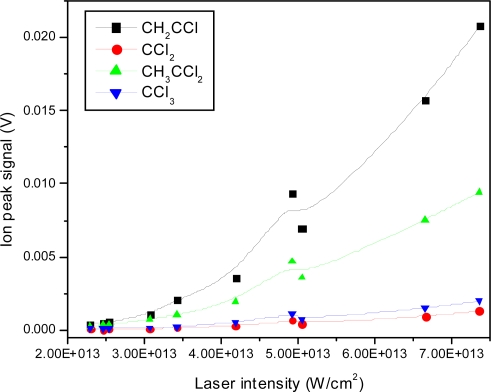
Ion peak signals as a function of laser intensity for CH2C35Cl+, C35Cl2+, CH3C35Cl2+, C35Cl3+ fragment ions using 397 nm laser radiation with 150 fs pulse duration.